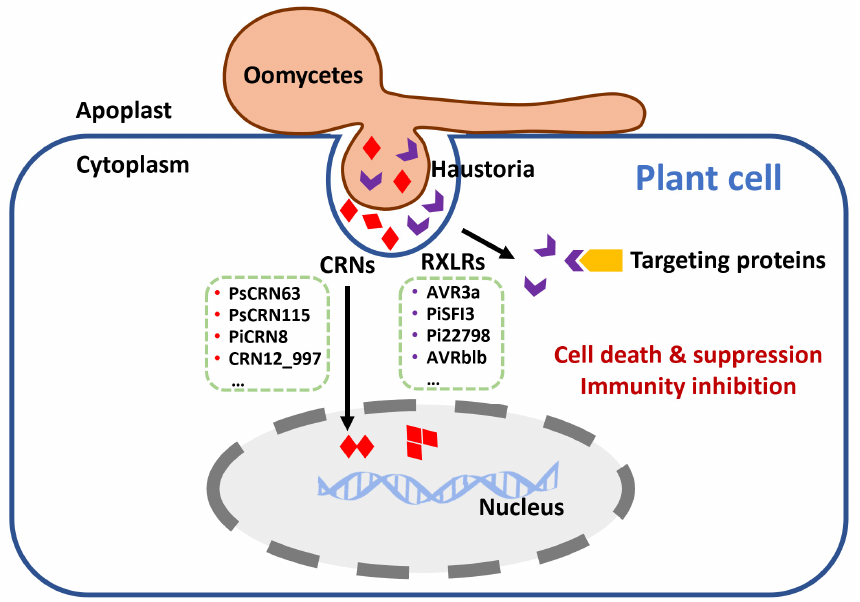
Figure 2. Oomycetous pathogens secrete RXLR and CRN effectors to induce or suppress host cell death and inhibit host immunity. RXLR: RXLR motif (X means any amino acid); CRN: crinkling and